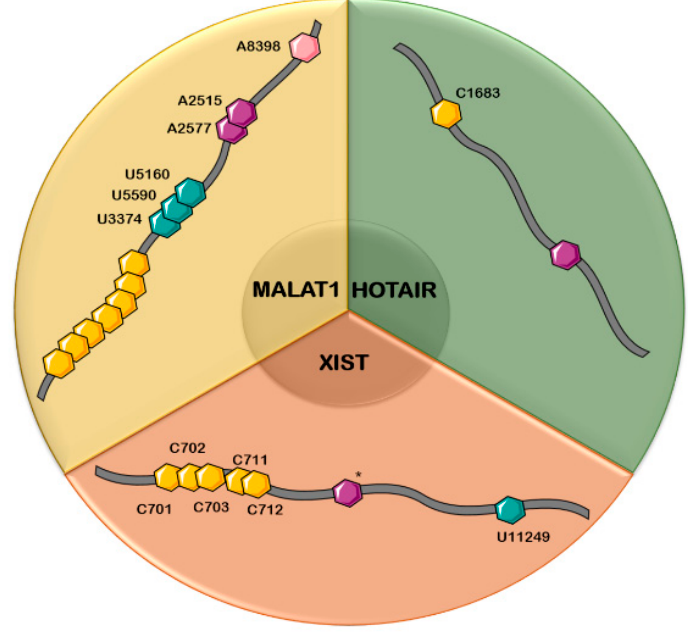
Figure 1. RNA modifications occurring in the main long non-conding RNAs (lncRNAs) and their positions: MALAT1, HOX antisense intergenic RNA (HOTAIR), and X-inactive specific transcript (XIST). *Different numbers of m 6 A sites are reported in XIST (presented in Table 2). Blue hexagon — ψ modification, purple hexagon—m 6 A modification, yellow hexagon—m 5 C modification, pink hexagon—m 1 A modification.